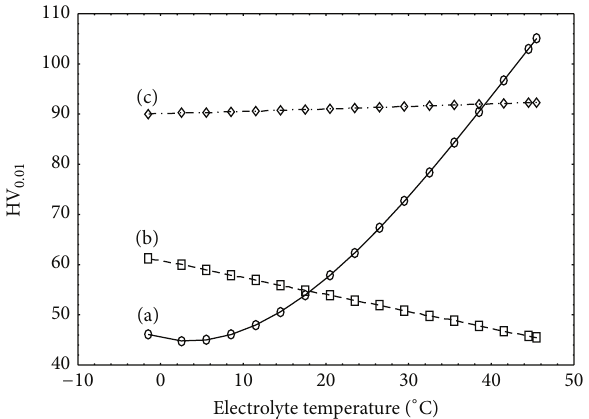
Figure 6: The dependence of the layer microhardness on the tem- perature of the electrolyte: c (H 2 SO 4 ) = 2.76 mol ⋅ L −1 , c (C 2 H 2 O 4 ) = 0.06 mol ⋅ L −1 , U = 10V, t = 15min. (a) 1A ⋅ dm −2 , (b) 3A ⋅ dm −2 , and (c) 5 A ⋅ dm −2 .